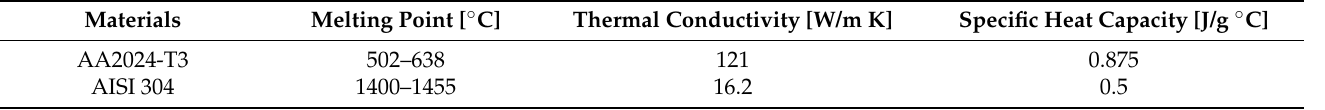
Table 2. Thermal properties of used